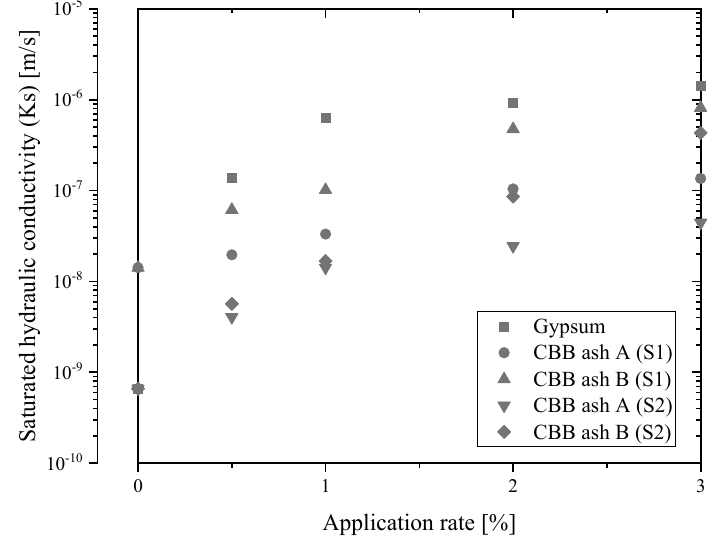
Figure 2. Changes in saturated hydraulic conductivity of salt-affected soils (soil 1 (S1) and soil 2 (S2)) at different application rates of CBB ash A, CBB ash B, and gypsum.